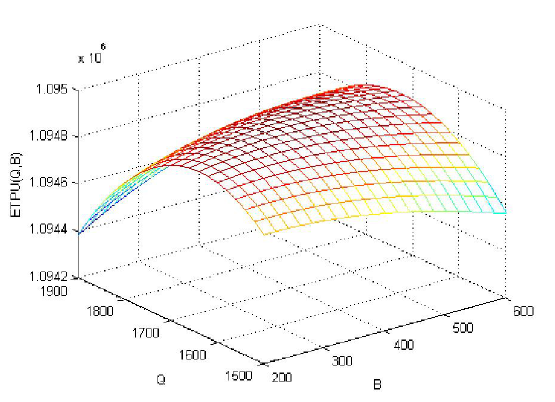
Fig. 2. The expected annual